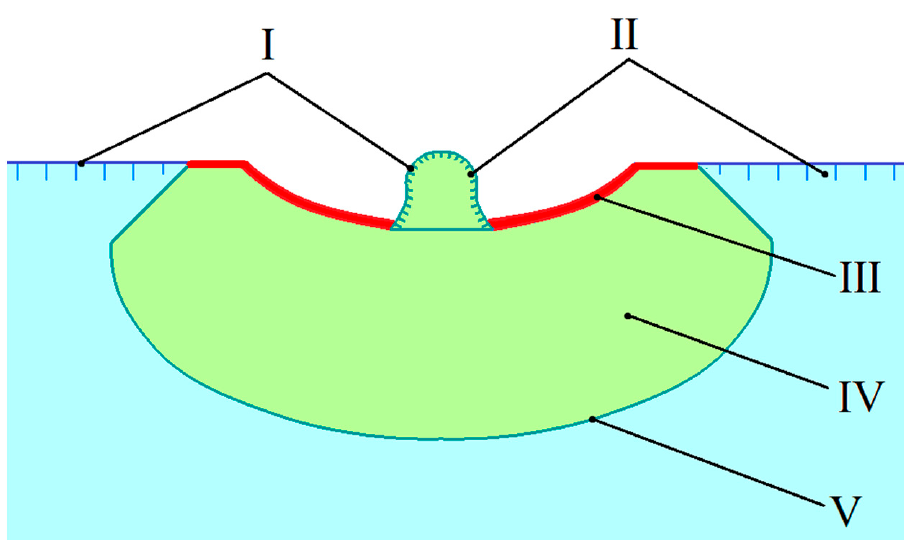
Figure 17. Scheme of drop merging with a target fluid in an intrusive mode: I—surface layers of the target fluid and drop, II—sub-surface layers, III—energy-saturated interface, IV—intrusion of the drop substance, V—boundary of the intrusion.